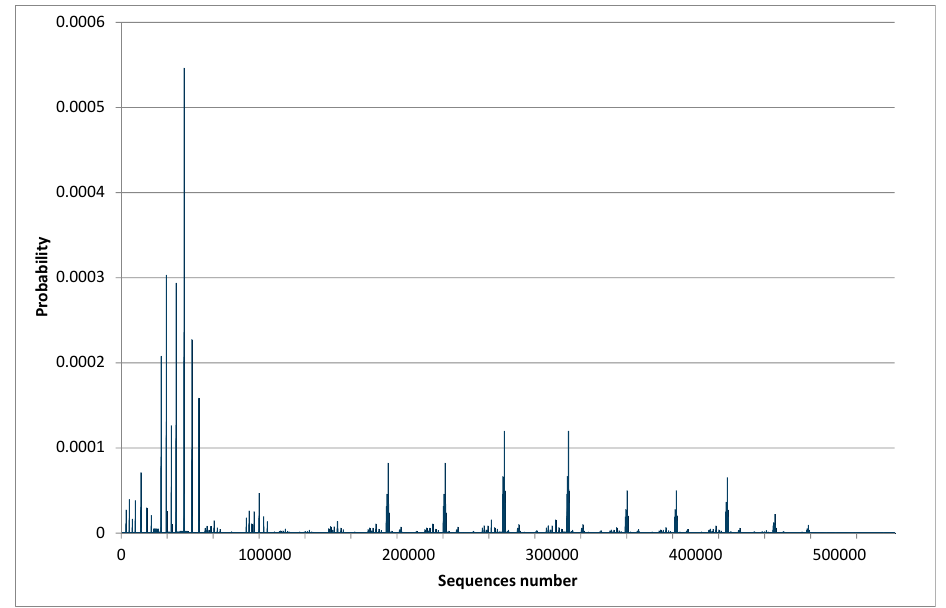
Figure 6. Details of the results bringing to high concentrations of VOCs in the output stream for the fixed bed based plant ( a ) The 100 sequences with the higher value of out-service time risk; ( b ) The 100 sequences with the and higher value of risk of operational cost.